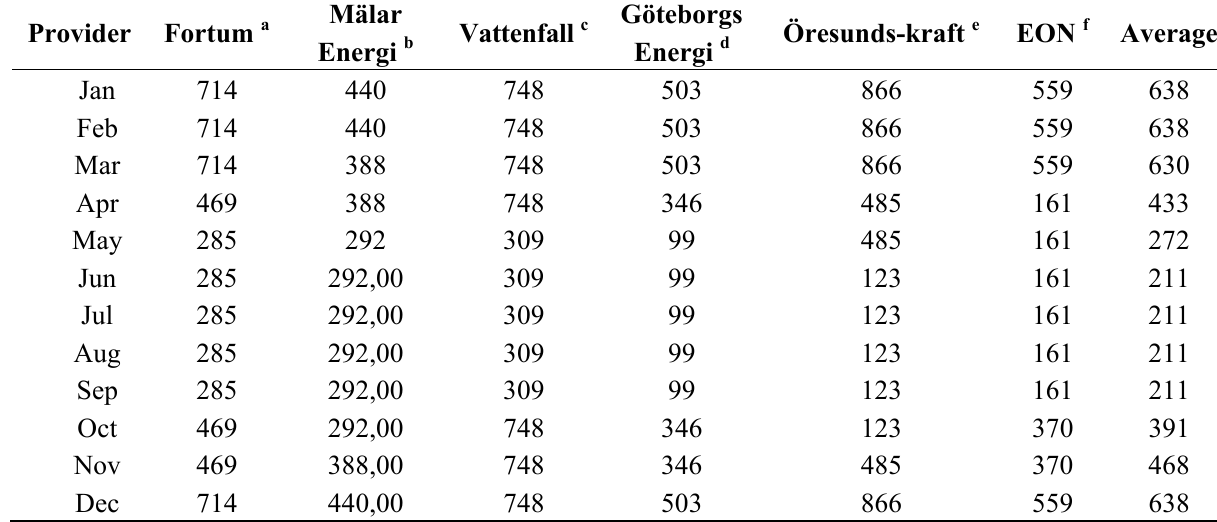
Table 2. Price of heat from urban district heating networks in Sweden